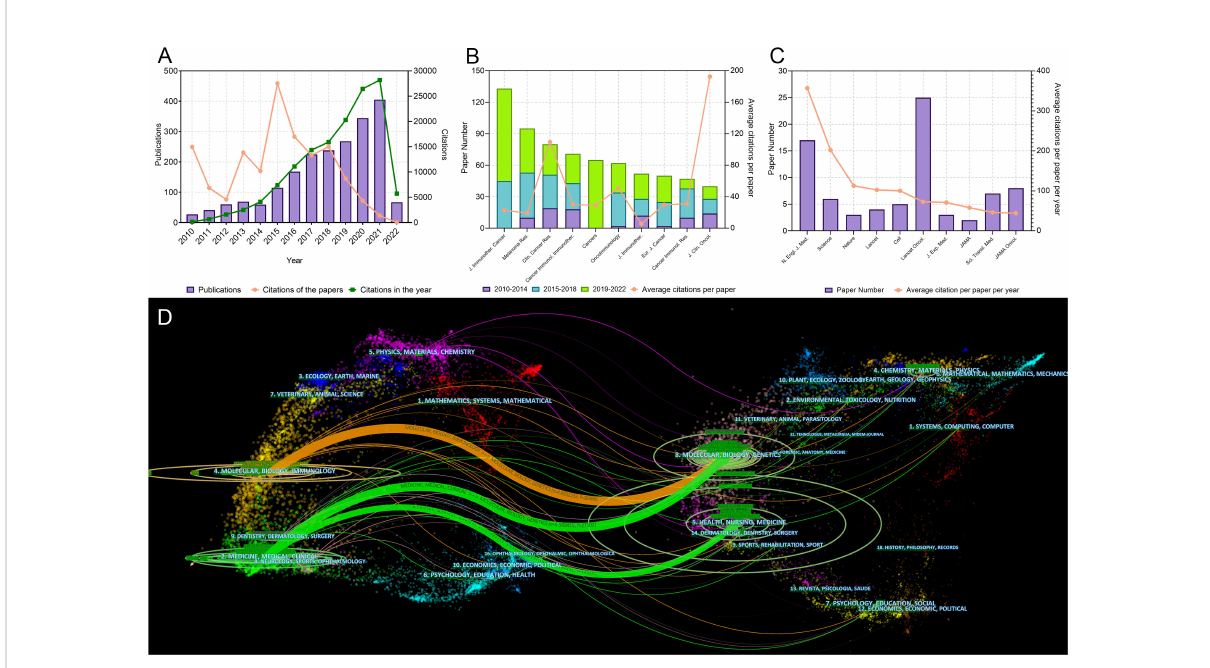
TABLE 1 The 10 most cited papers in melanoma immunotherapy between 2010 and 2022a a . Rank Title